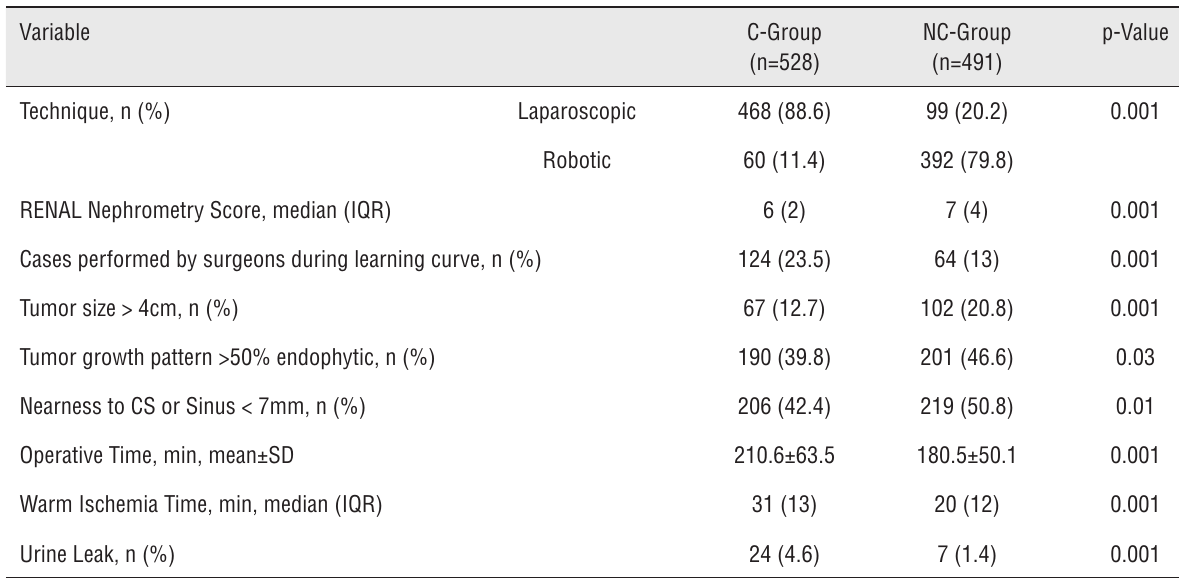
Table 3 - Comparison between Populations under Study